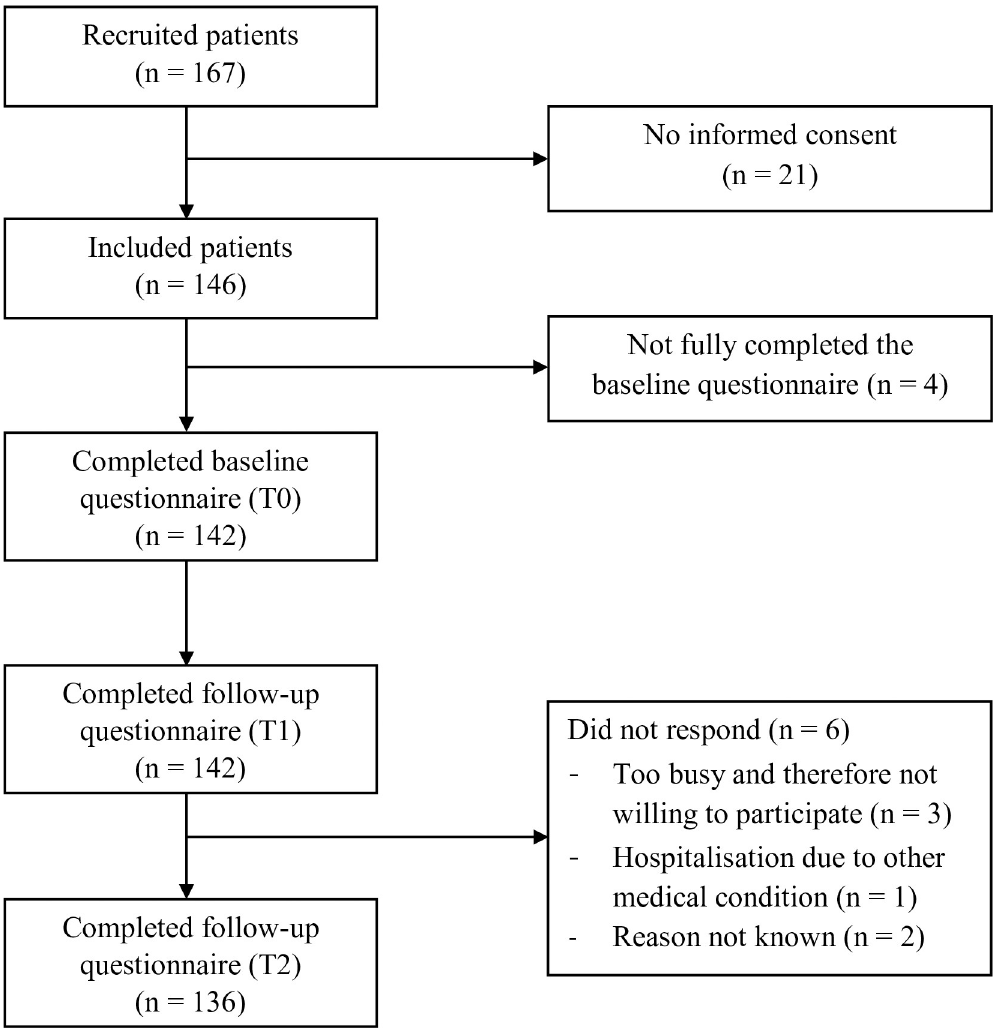
Fig 2. Flowchart for inclusion of